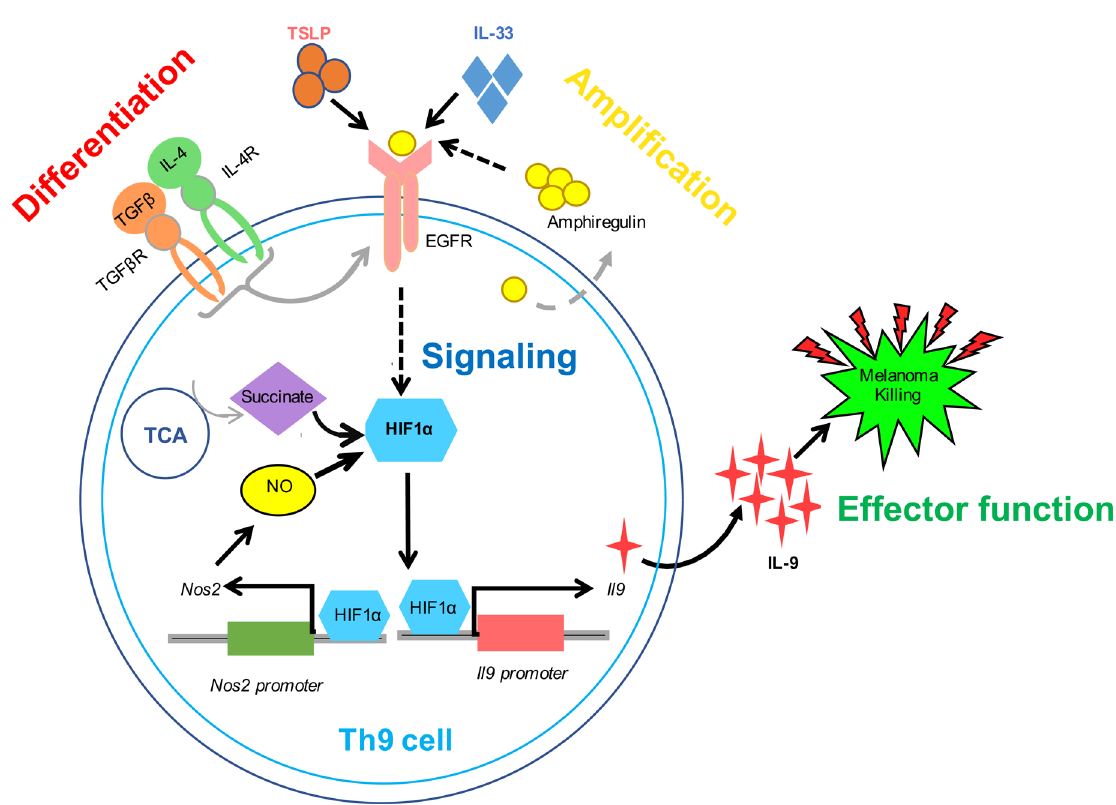
Fig. 8 Schematic representation of EGFR-HIF1 α signaling pathway in Th9 cells. TGF- β 1 and IL-4 initiates the “ differentiation ” of naïve CD4 + T cells into Th9 cells, which expresses EGFR and produces EGFR ligand, Areg. Areg “ ampli fi es ” Th9 cell differentiation via activating EGFR in a feed-forward loop. Upon activation, EGFR triggers downstream “ signaling ” through HIF1 α which transactivates Il9 and Nos2 promoters resulting in enhanced IL-9 induction. Succinate, a TCA cycle metabolite, and nitric oxide (NO) further stabilizes HIF1 α potentiating Th9 cell differentiation and anti-tumor effector